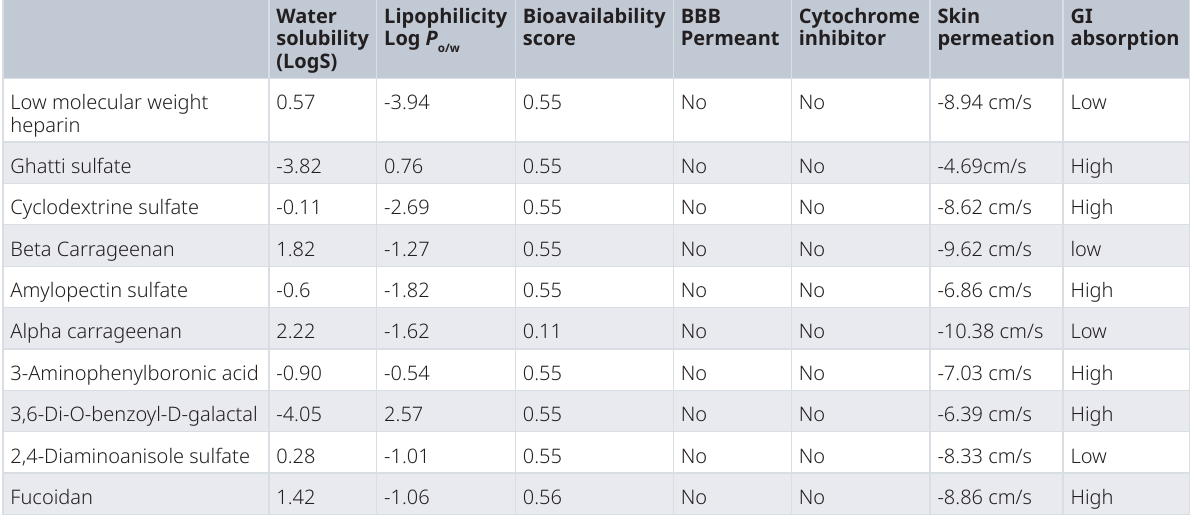
Table 7. ADMET analysis data for screened drug compounds. The compounds are highly soluble in water with logS score greater than -4 which is the range of most market drugs. The compounds have high gastrointestinal absorption except for carrageenan and 2,4-Diaminoanisole sulfate. The bioavailability value is highly significant for most of the compounds. The drug compounds do not inhibit cytochromes hence no formation of toxic compounds. Skin permeation values are negative depicting less permeation. Lipophilicility greater than 1 in 3,6-Di-O-benzoyl-D-galactal and ghatti sulfate shows the ability of these compounds to reach target